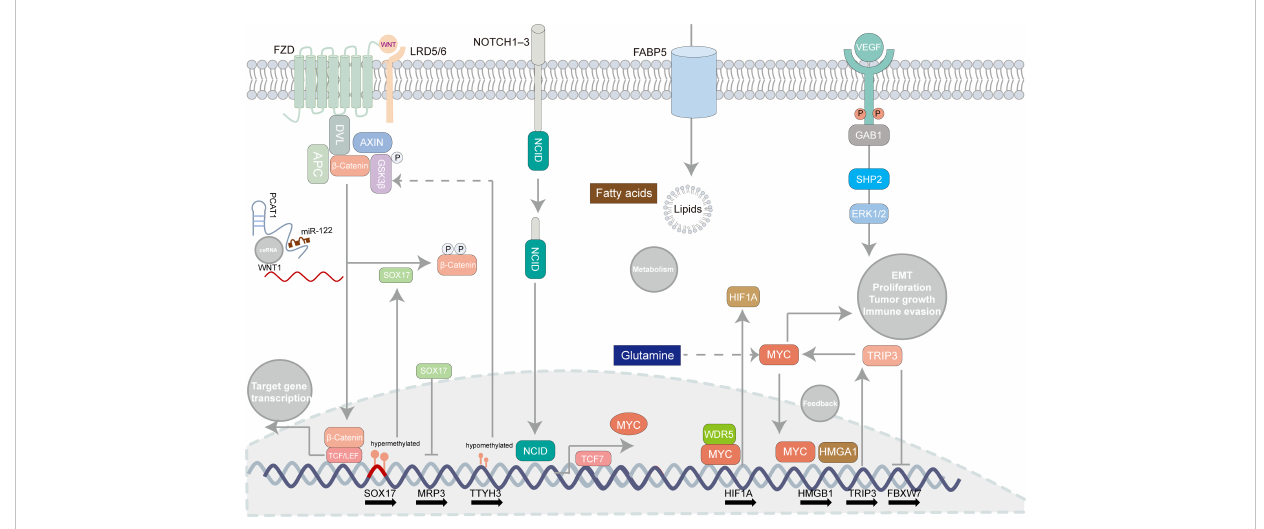
FIGURE 3 Oncogenic pathways involved in extrahepatic cholangiocarcinoma. Some canonical pathways can be related to tumorigenesis in extrahepatic cholangiocarcinoma such as the Notch signaling pathway, the WNT/ b -catenin pathway, the MYC-oncogene pathways, lipid metabolism, and angiogenesis. Several regulatory mechanisms concerning those pathways are recapitulated in the